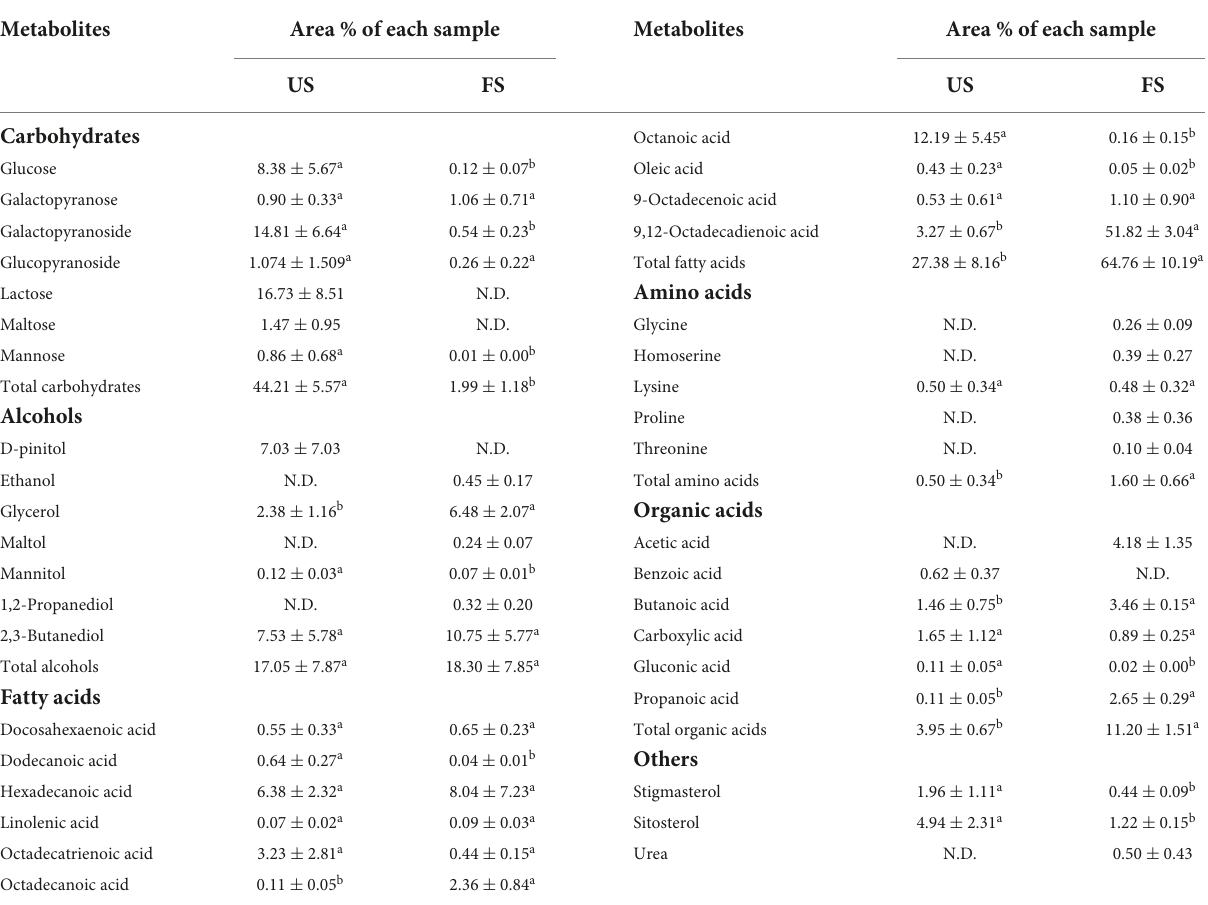
TABLE 2 Metabolites detected by GC-MS analysis in US and